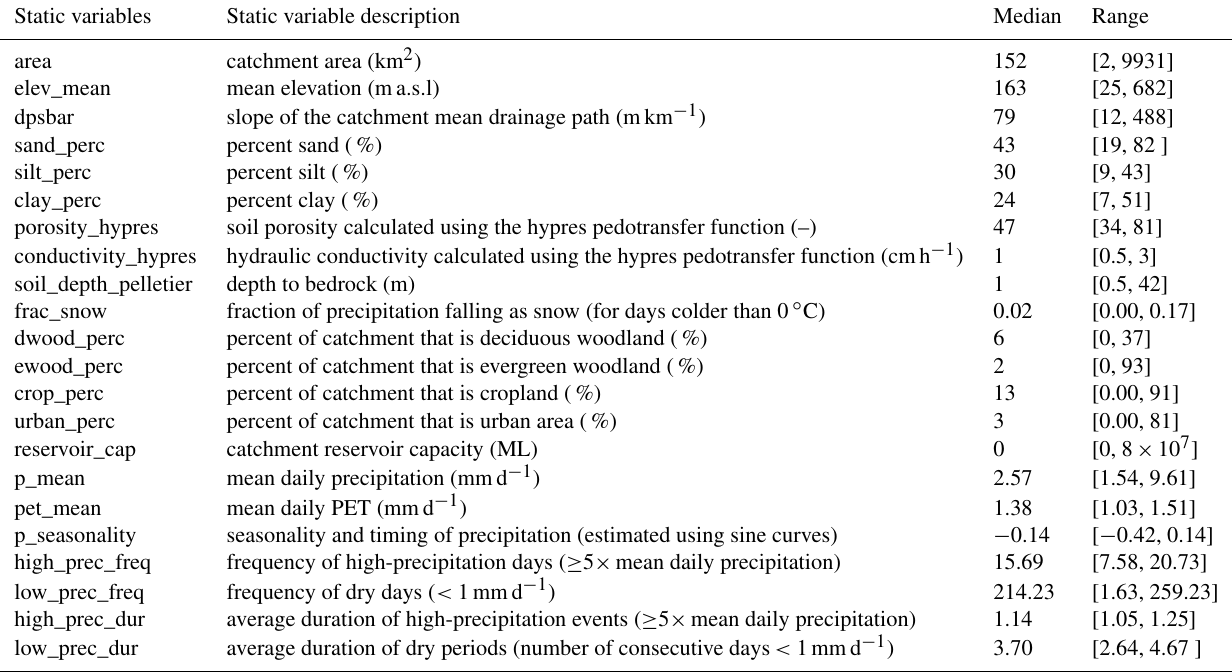
Table 1. Catchment attributes from the CAMELS-GB dataset (Coxon et al., 2020b) used to train the LSTM-based models and the static features included in A .